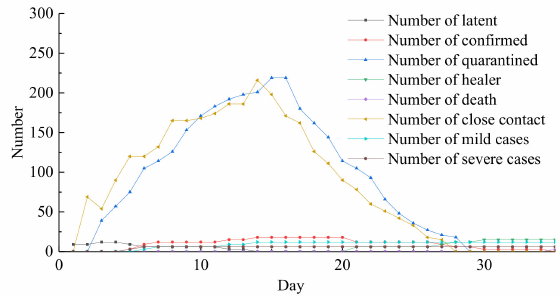
Figure 9. Multi-intervention combination